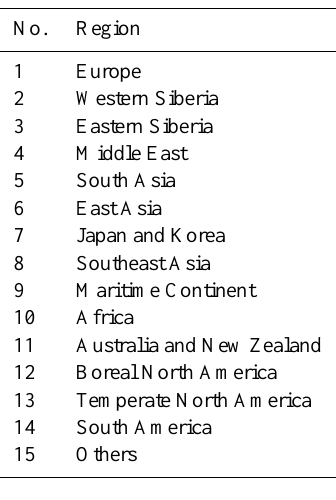
Table 1. Regions assigned for tagged tracer